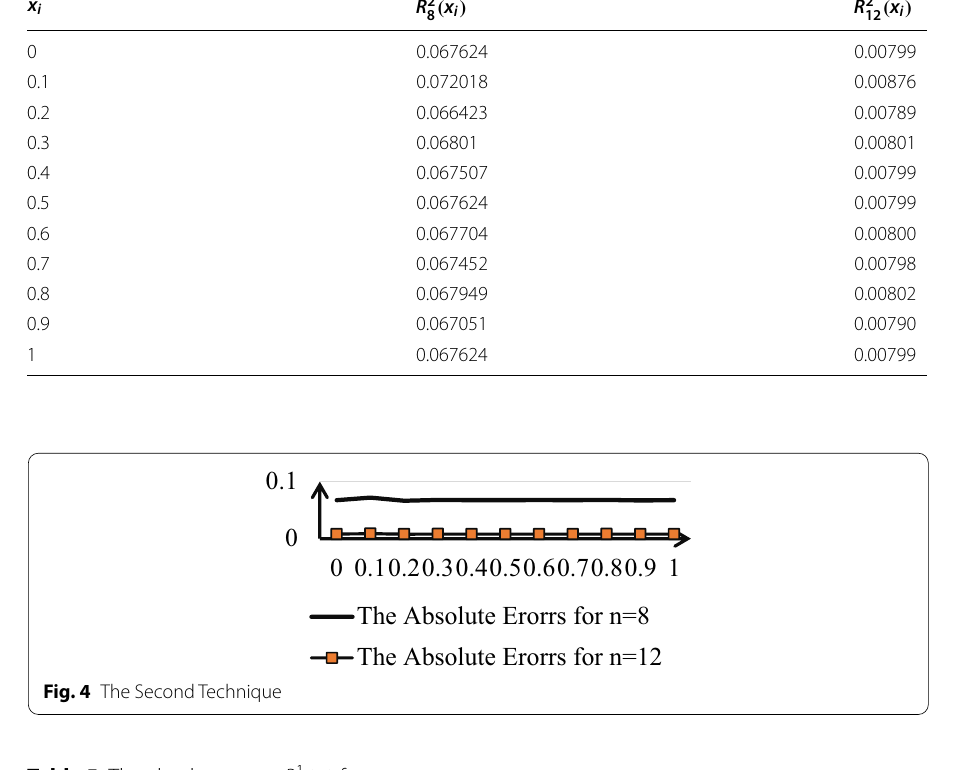
Table 5 The absolute errors R 1 n ( x i ) for n = 3,